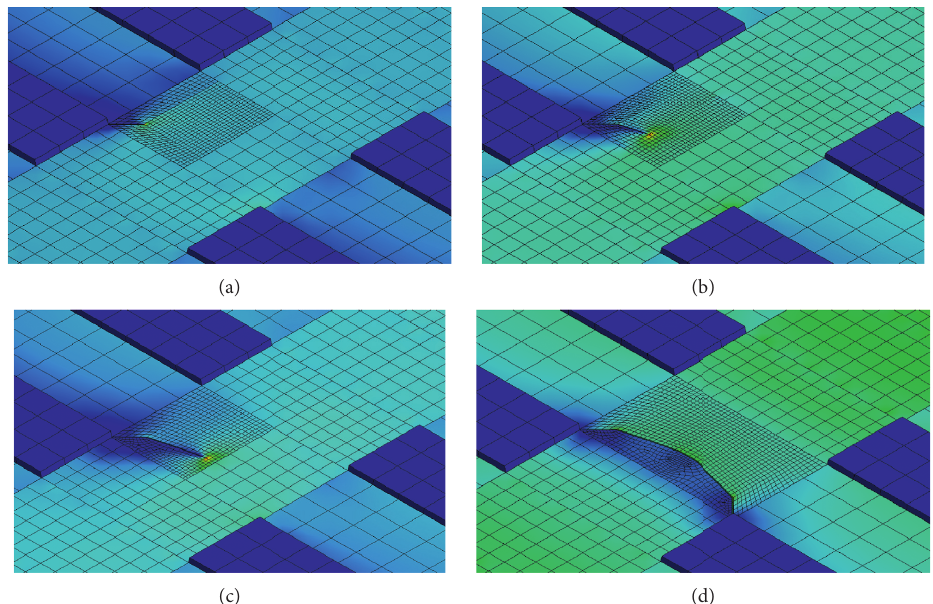
Figure 23: Predicted propagation paths of the crack with an initial angle of 45 ° . (a) θ � 30.06 ° , (b) θ � 1.53 ° , (c) θ � 2.65 ° , and (d) crack